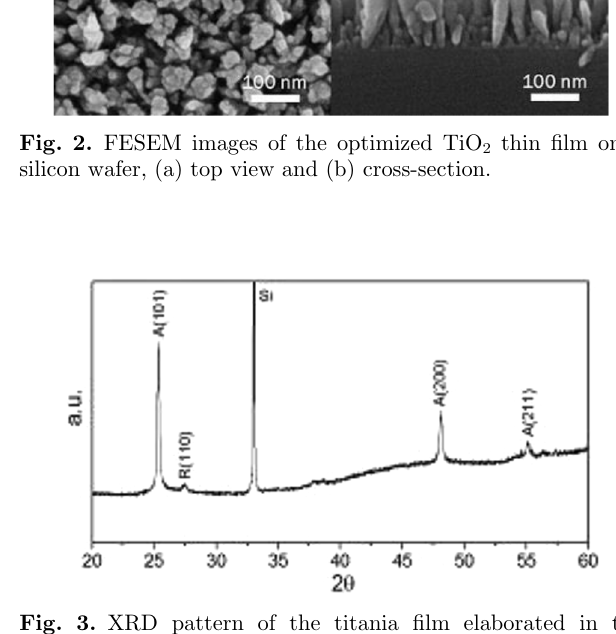
Fig. 3. XRD pattern of the titania fi lm elaborated in the optimized